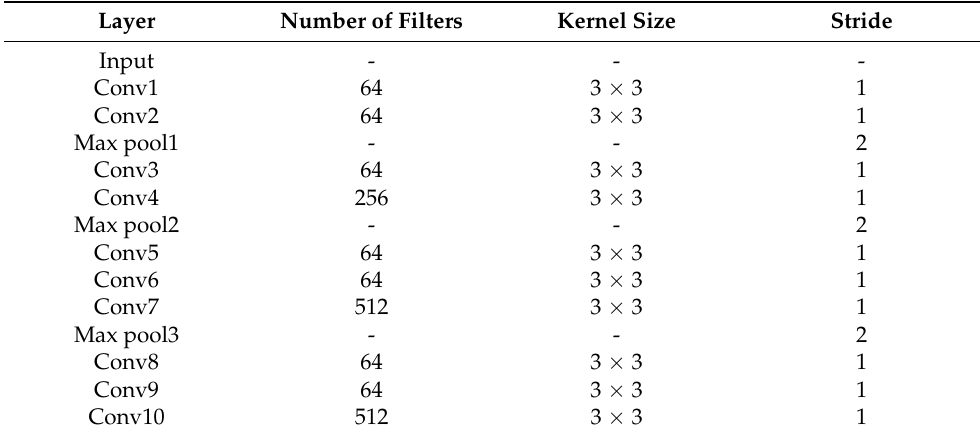
Table 1. The structure of the student network in the